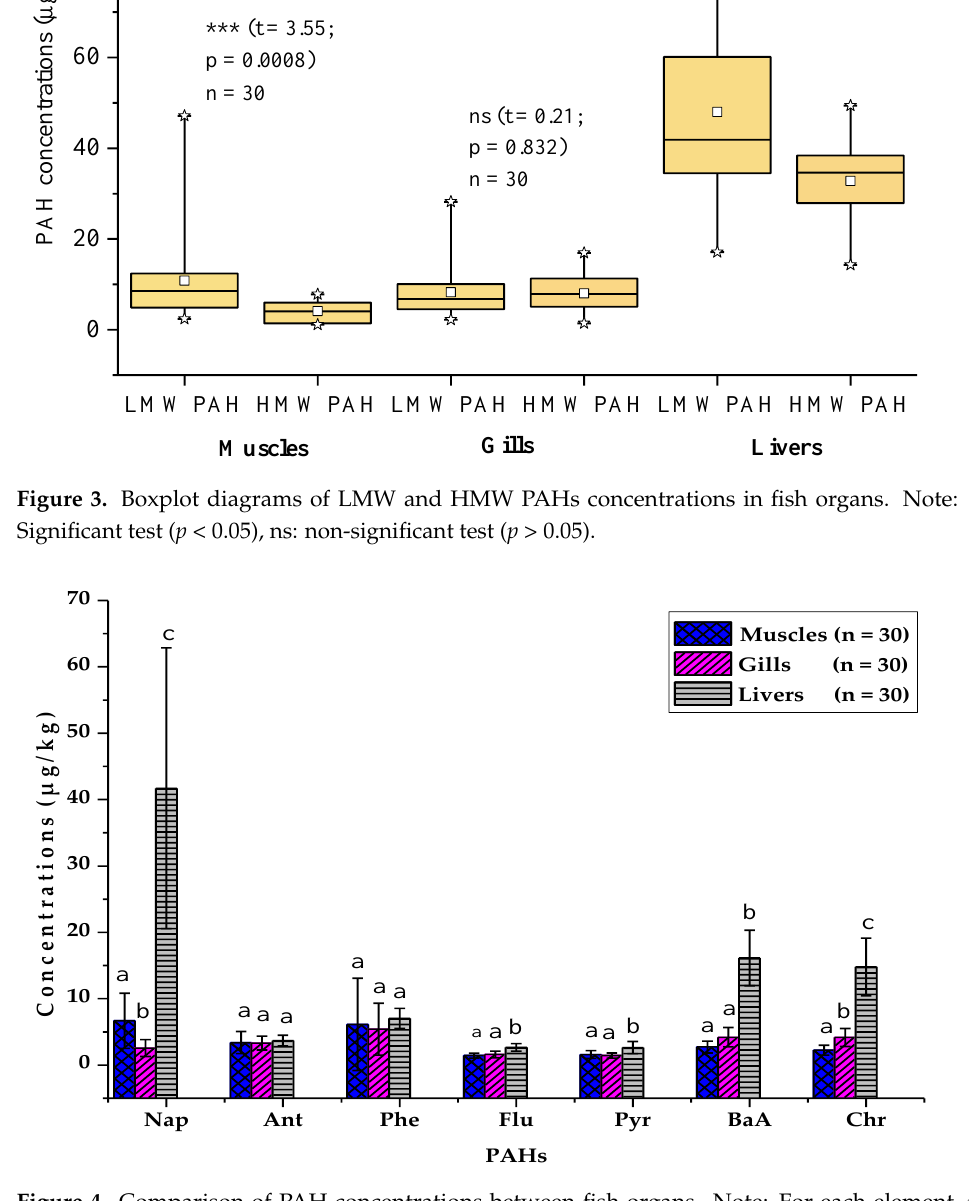
Figure 4. Comparison of PAH concentrations between fish organs. Note: For each element, the organs bearing the same letters are statistically homogeneous unlike those bearing different letters (ANOVA followed by Newman-Keuls test).